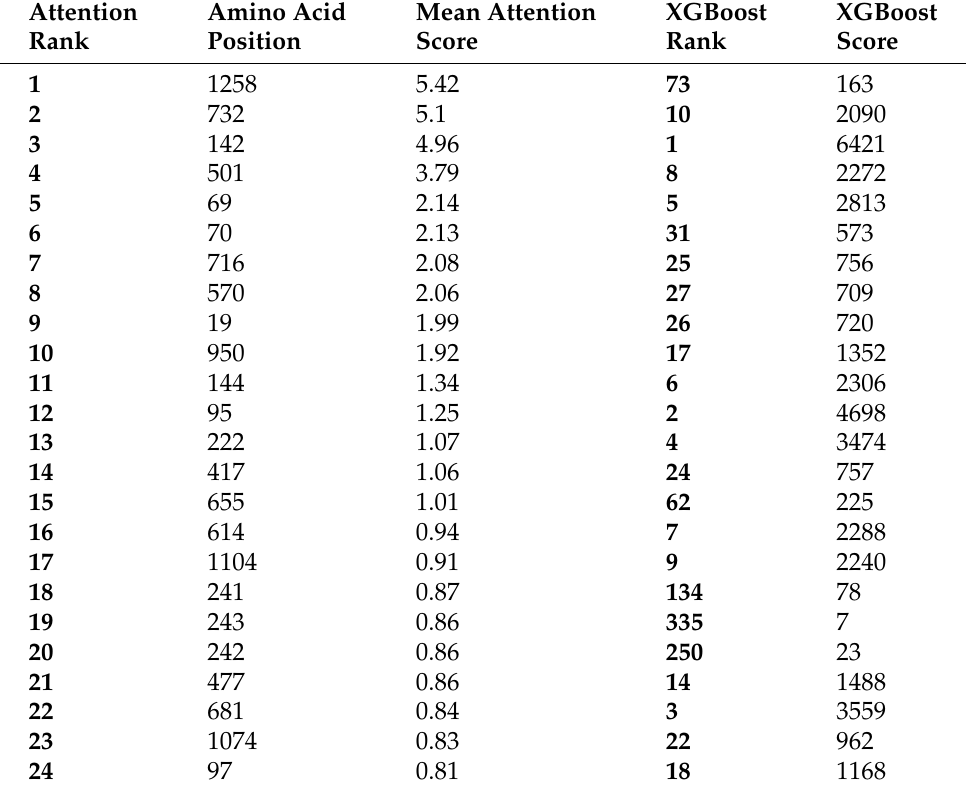
Table 4. Amino acid positions with the highest mean attention and XGBoost scores. Attention rank and scores are compared to the XGBoost feature importance ranking and scores (obtained from the gain measure of feature importance). This table includes the 10 highest-scoring features identified by XGBoost, which appear within the 22 highest attention